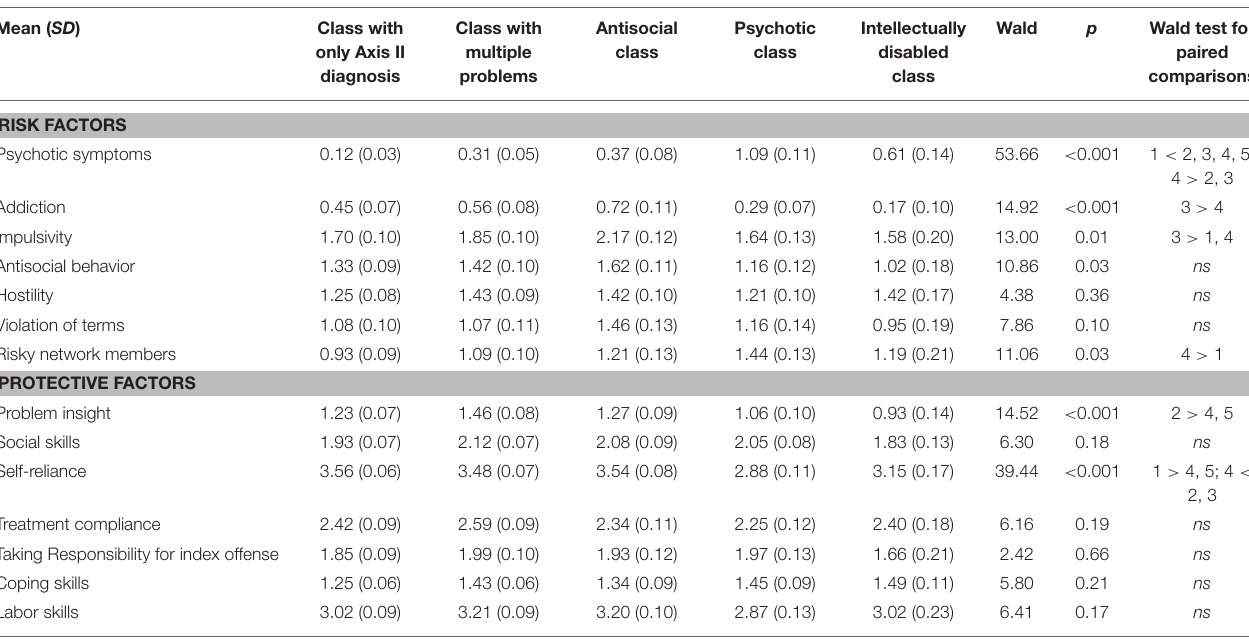
TABLE 7 | Class-specific means of risk and protective factors at item